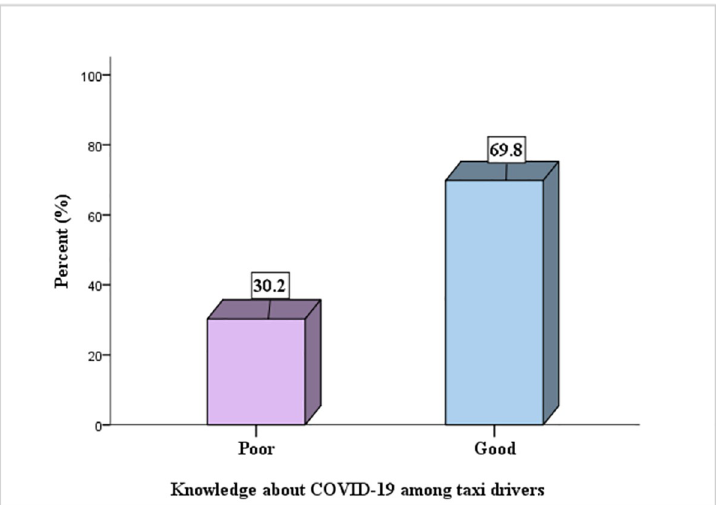
Fig 1. Knowledge about COVID-19 among taxi drivers in Dessie City and Kombolcha Town, Ethiopia, July to August